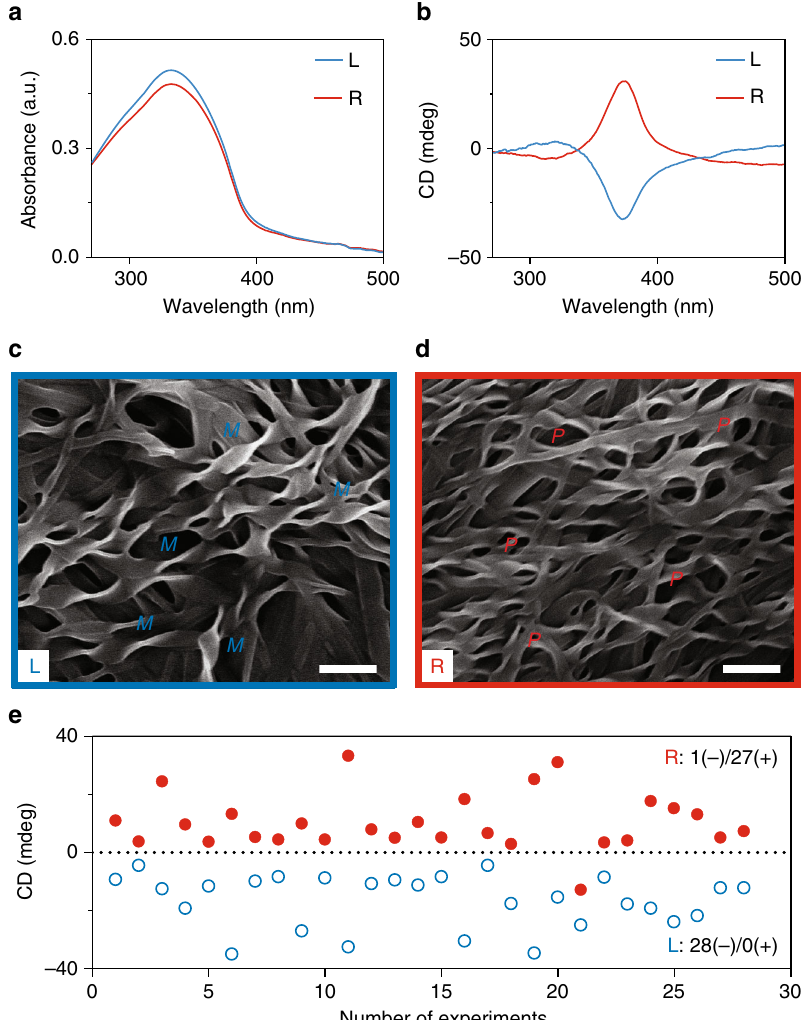
Fig. 2 Microvortex selection of supramolecular chirality of BTAC gels. a UV-Vis spectra of BTAC gels. The blue (red) line refers to measurement from the gels collected from the L- (R-) outlet. b CD spectra indicate opposite chirality for BTAC gels collected from different outlets. c , d SEM characterizations show predominantly M and P twists for BTAC gels from the L- and R-outlet, respectively. Size of chiral twists is 295.2± 10.8 nm in width, and 869.3 ± 31.1 nm in length (mean ± s.e.m.; n = 40). Scale bars, 1 μ m. e CD signals of 28 independent experiments indicate nearly absolute chirality control of BTAC gels by microvortices. The void blue (solid red) circles indicate CD signals of gels from the L- (R-)